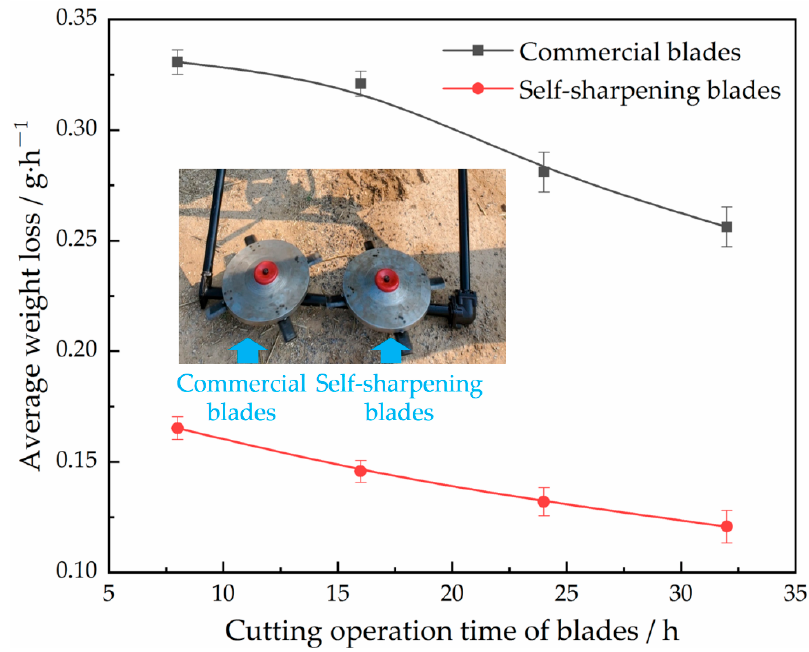
Figure 4. Average weight loss rate of different blades in the same cutting operation time.